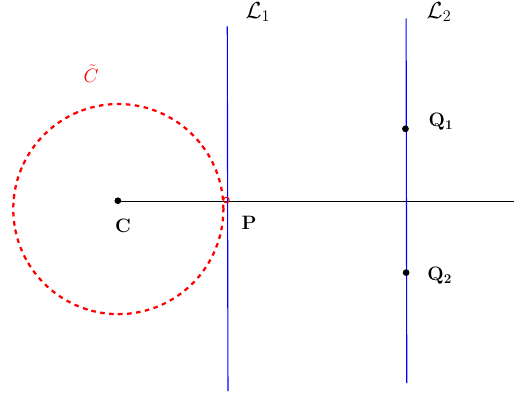
Figure 2. The case of hyperbolic affine rotation surfaces